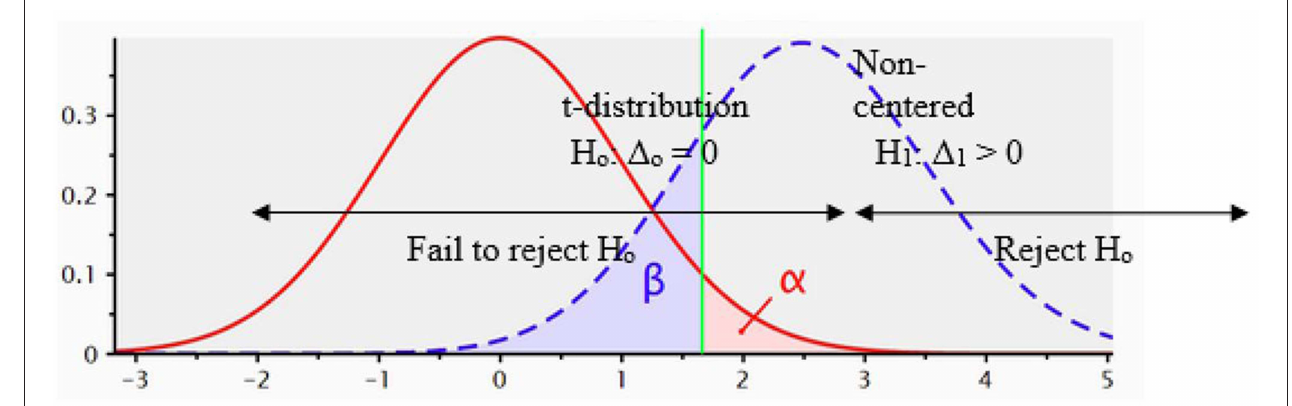
TABLE 1 | Safety Index (and percentage of damage) as a function of the probability of detection and the probability of false alarms—fundamental frequency. Probability of false alarms Damage at 0.17L Damage at 0.65L Probability of detection